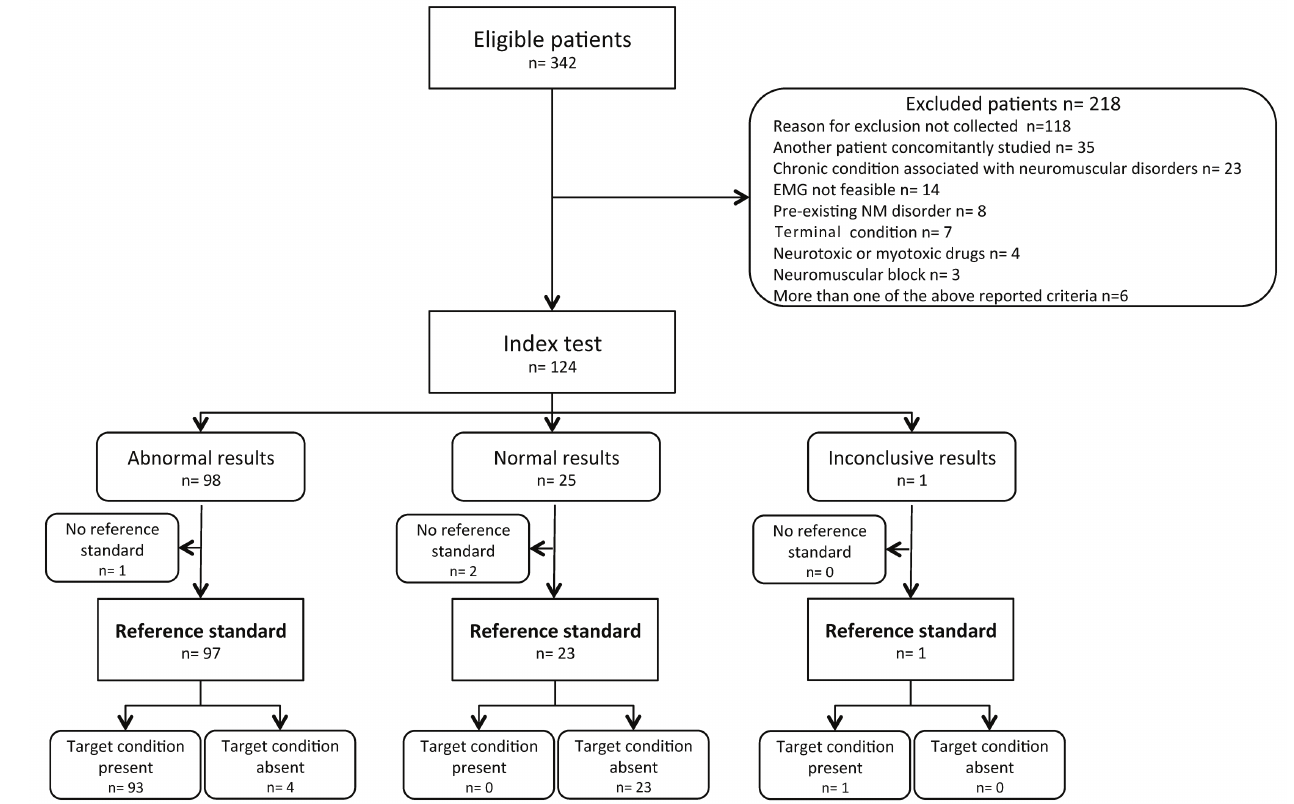
Figure 2. Standards for Reporting of Diagnostic Accuracy (STARD)